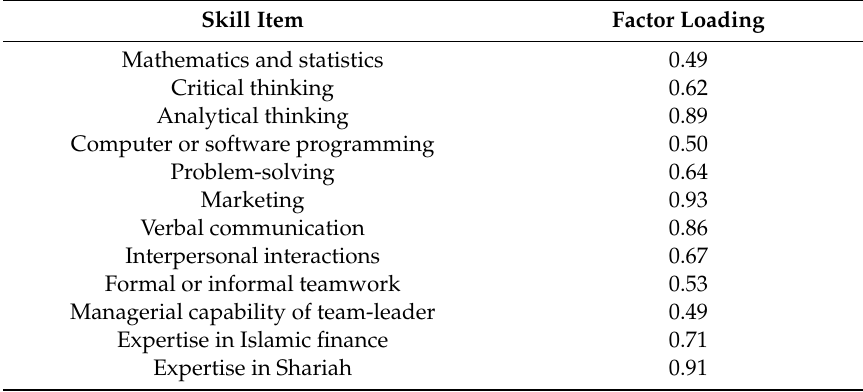
Table A2. Factor loadings and Common Method